Question: In one sentence, what is this figure communicating?
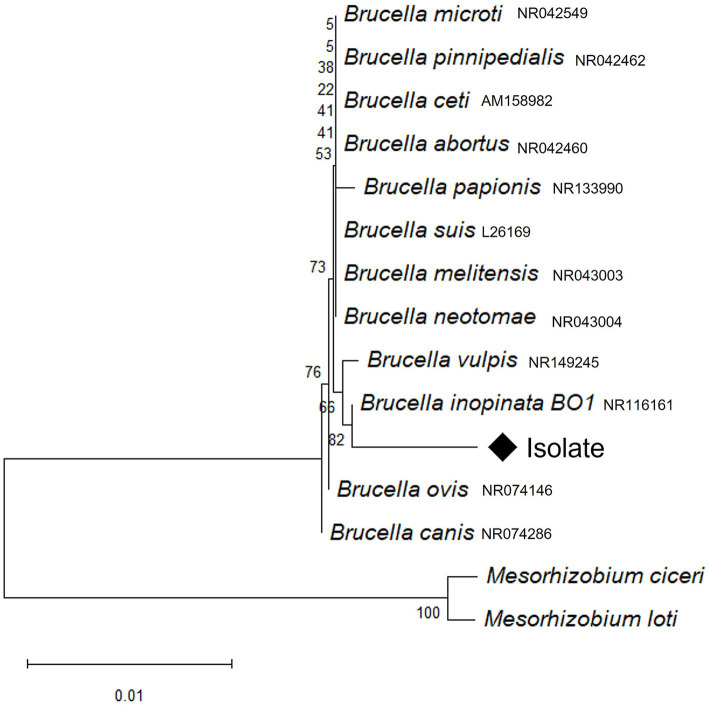
Answer: Neighbor-joining phylogenetic analysis based on 16S ribosomal RNA gene sequences in the GenBank database. A black diamond (◆) indicates the Brucella sp. identified in the waxy monkey treefrog ( Phyllomedusa bicolor ) in this study. Sequence alignments were performed using ClustalX version 1.8 ( 34 ); MEGA-X version10.1 ( 35 ) was used for phylogenetic analyses. Bootstrap percentage values are shown on the branches.